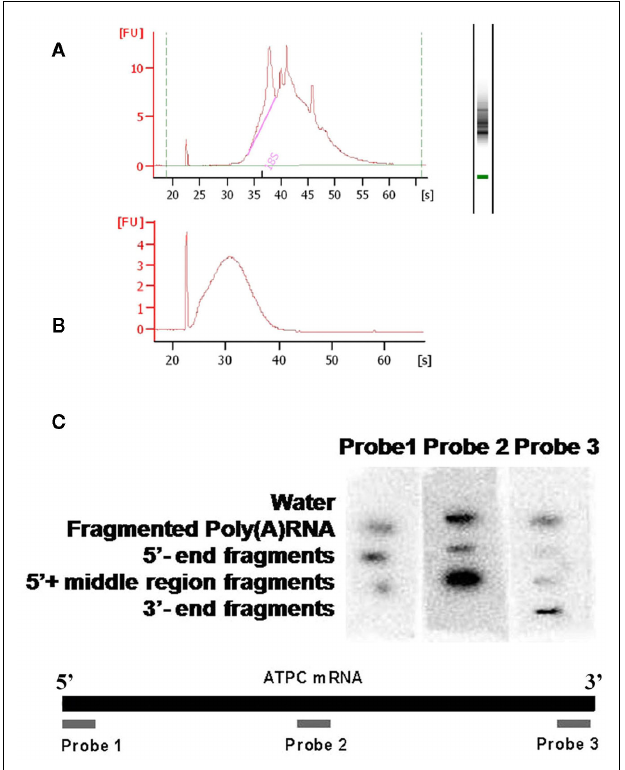
FIGUREA2 | Quality control of fragmented mRNA. The poly(A) RNA used for the fragmentation experiments was purified using oligo(dT) at least three times, the quality of the mRNA was confirmed by RNA6000 LabChip (Agilent) (A) . After fragmentation the average fragment size was confirmed by RNA6000 LabChip (Agilent) (B) . A dot-blot was used for confirming that the fragments after fractionation were enriched in the predicted parts of the mRNA pool. Probes were made from the 5 (cid:2) , the middle and the 3 (cid:2) regions of the ATPC mRNA and it was hybridized to membrane bound RNA pools of the different fractionated fragments (C)